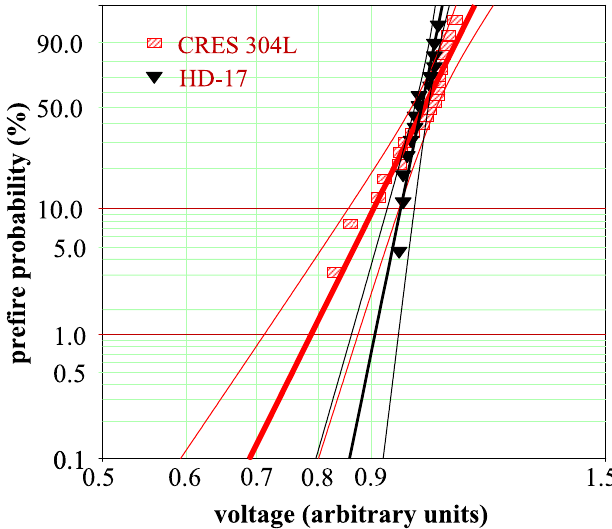
FIG. 12. (Color) Normalized prefire probability for CRES 304L and HD-17 trigger electrodes. Ninety-five percent confidence bands are also displayed. 2.89 bar with varying trigger gap distance, each of which resulted in a prefire rate of (cid:1) 2 : 5% . This prefire rate is commensurate with the self-closure data depicted in Fig. 12.